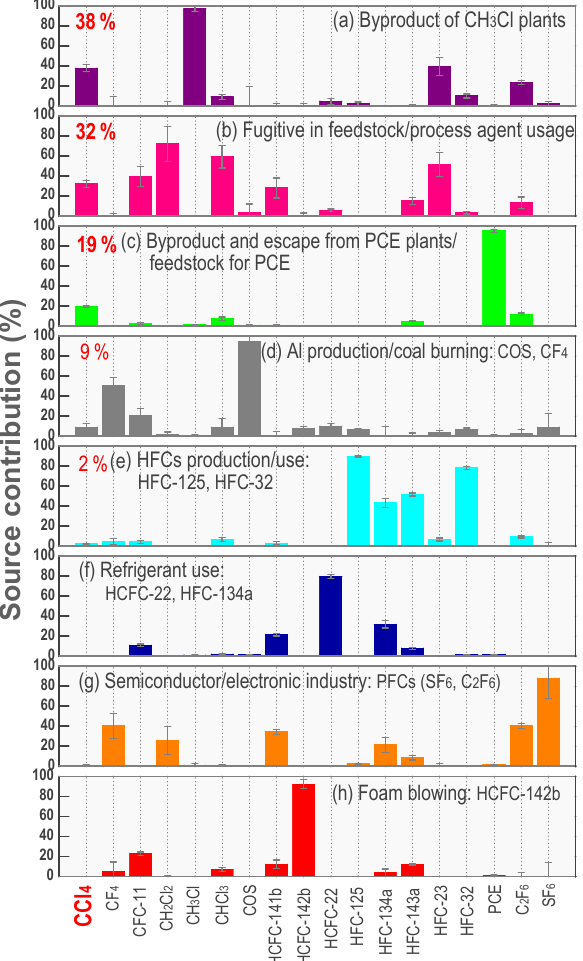
Figure 4. Source profiles derived from PMF analysis for 18 com- pounds, including CCl 4 , CFCs, HCFCs, HFCs, PFCs, SF 6 , COS, CH 3 Cl, CH 2 Cl 2 , CHCl 3 and C 2 Cl 4 . The PMF analysis is per- formed on the time series of enhanced concentrations. The y axis shows the percentage of all observed enhancements associated with each factor (with 1 σ standard deviation) such that the vertical sum for each species listed on the x axis is